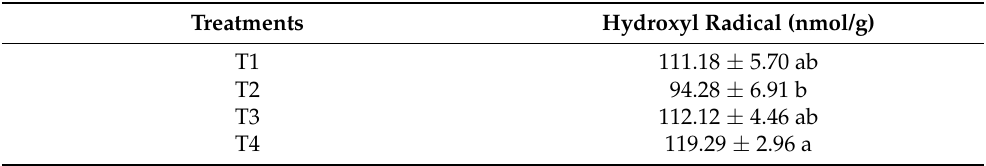
Table 6. Effects of endophytic B. bassiana on Hydroxyl radical (mean ± SE nmol/g) content in tomato leaves following exposure to pathogenic FOL.